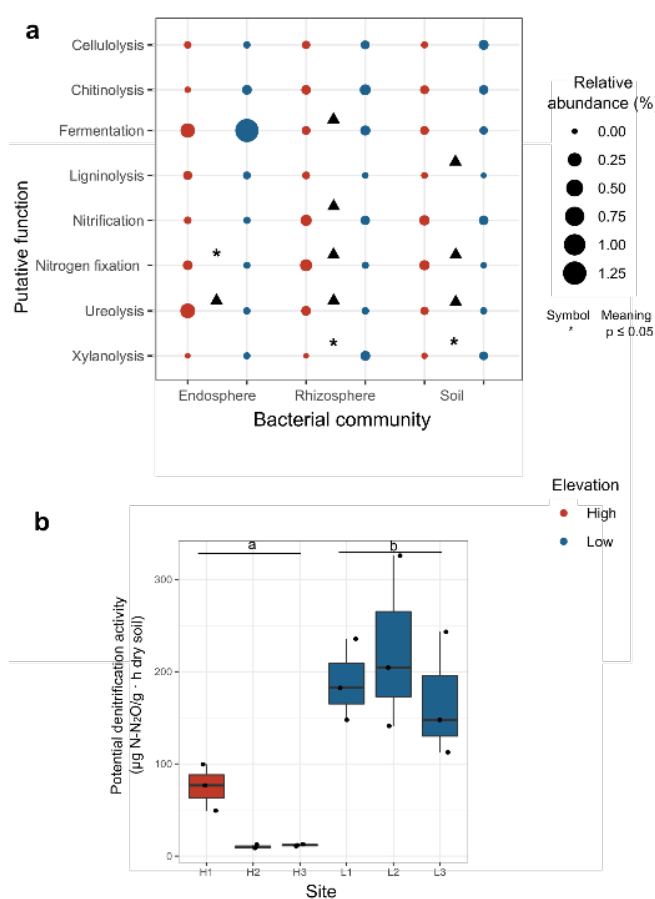
Figure 6. Potential function differences among elevations in each type of community. ( a ) Relative abundance of different functions based on the FAPROTAX database in the three types of communities. Elevation effect was tested with aligned rank transform for non-parametric factorial and significant differences are indicated with asterisks. Triangle symbols indicate potential functions that were increased in sites with a tendency to be higher in high or low elevation sites. ( b ) Potential soil denitrification activity. Different letters indicate significant difference among elevations (t-Welch test p < 0.05).